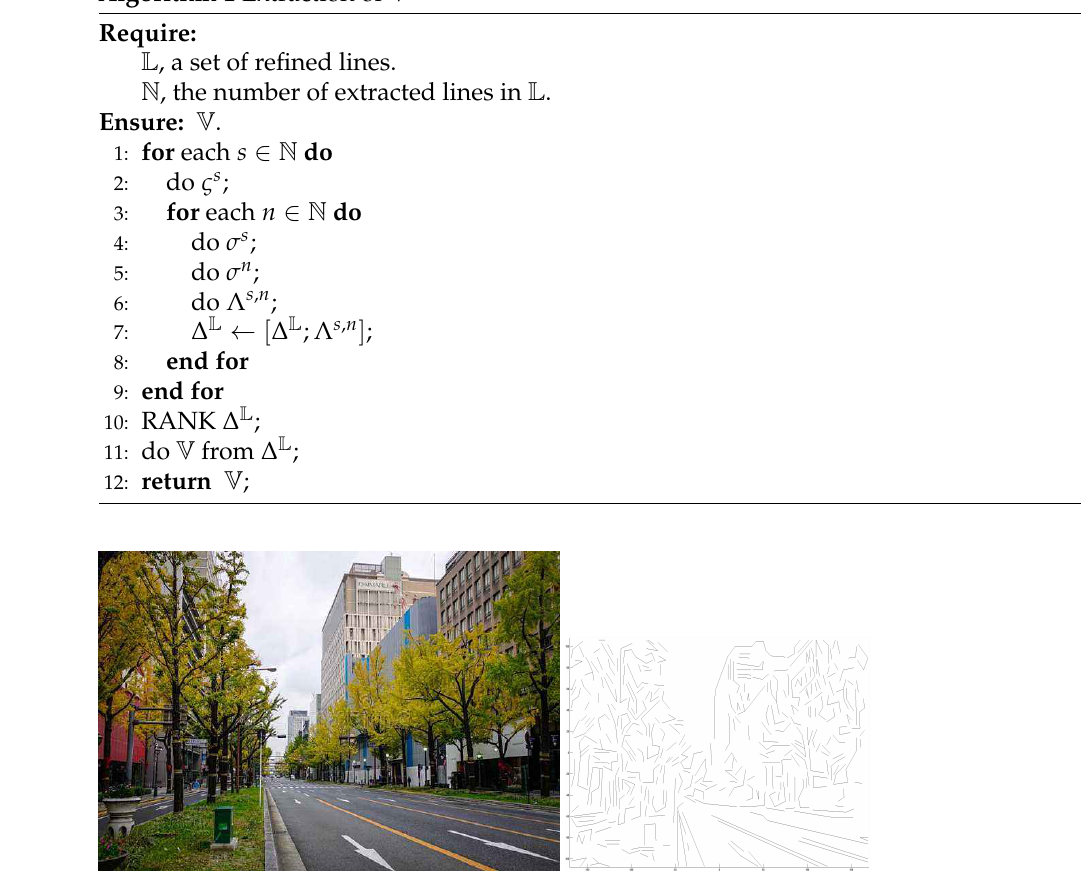
Algorithm 1 Extraction of V